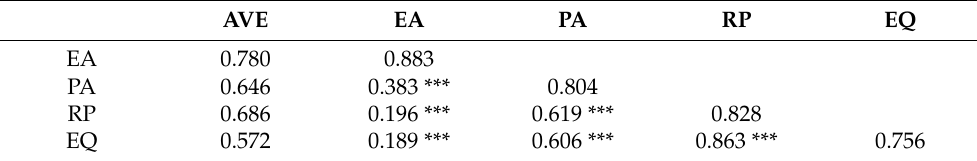
Table 8. Results of correlation analysis.